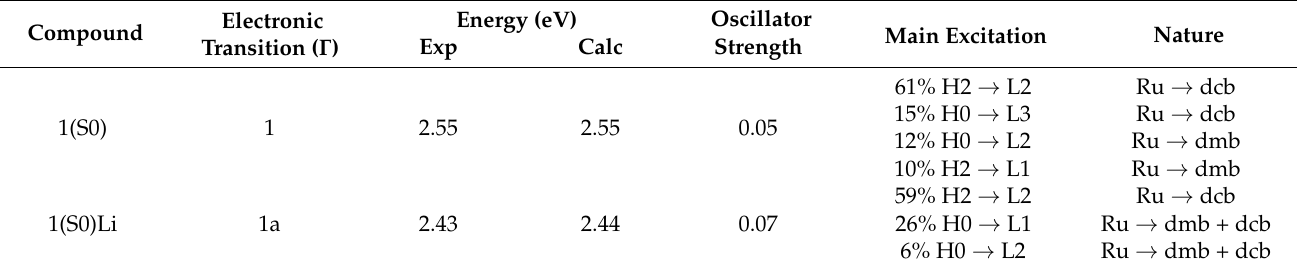
Table 7. TDDFT results for complexes 1 and 1 +